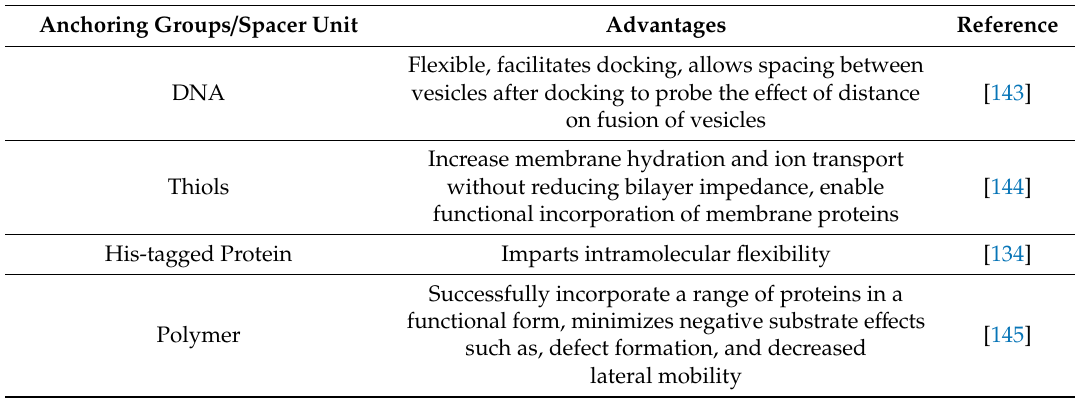
Table 4. Types of anchoring groups for creating tethered lipid